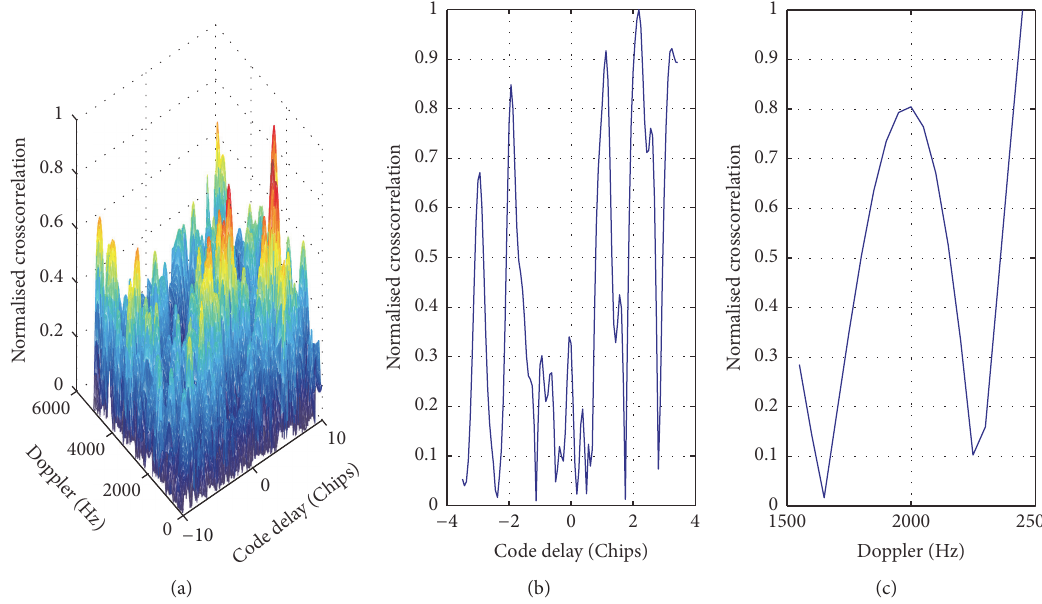
Figure 19: Correlation peaks after interference suppression by DST-MPDR beamformer for scenario 2.